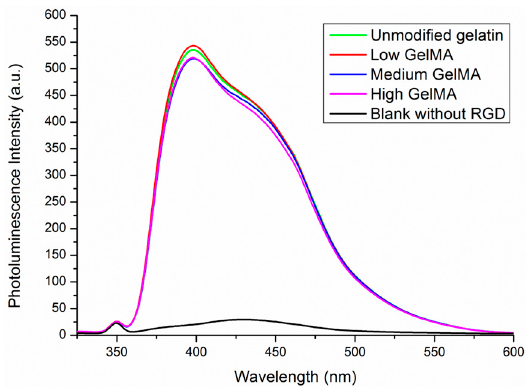
Figure 2. Photoluminescence spectra of 9,10-phenanthrenequinone after reaction with gelatin and GelMA macromers.